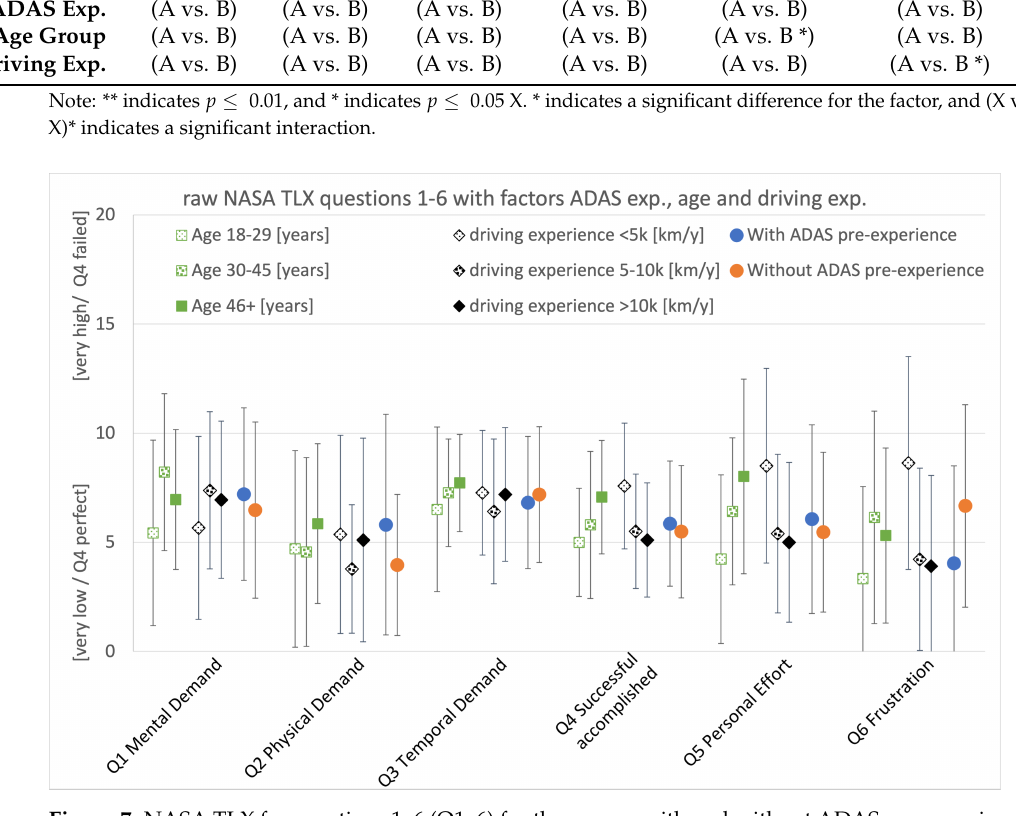
Figure 7. NASA TLX for questions 1–6 (Q1–6) for the groups with and without ADAS pre-experience, the groups of driving experience per year, and the age